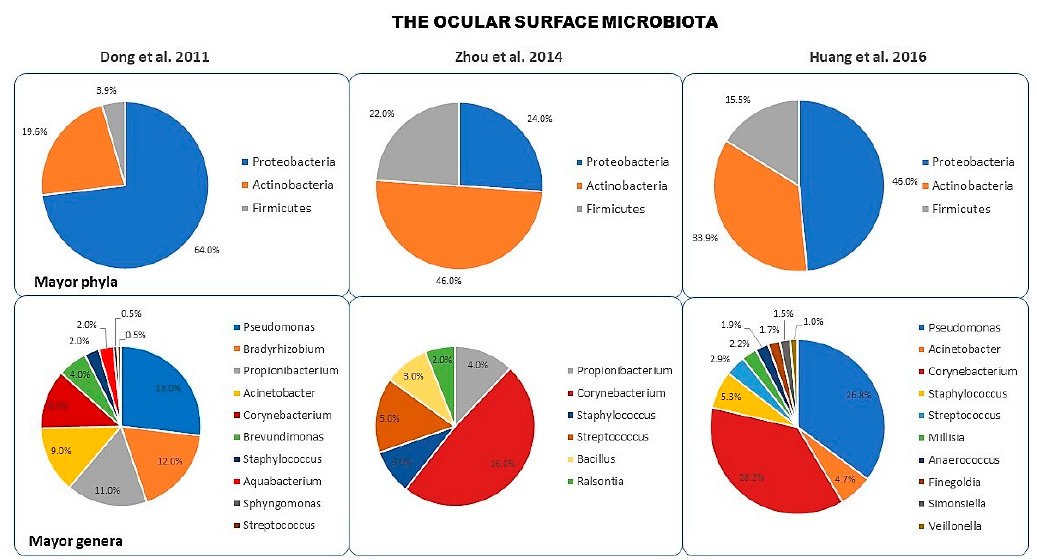
Figure 2. Relative abundance of major phyla and mayor genera found in the ocular surface using 16S rRNA gene reads. Dong et al. analyzed 115,003 sequences in total (2011), Huang et al. analyzed 840,373 high-quality sequencing reads (2016), Zhou et al. generated 1,690,427 reads (2014). 4. E ff ects of Age, Sex, Ethnicity, and Geographic Location on the Ocular Microbiota Composition Studies conducted on the ocular microbiota have demonstrated changes from birth to